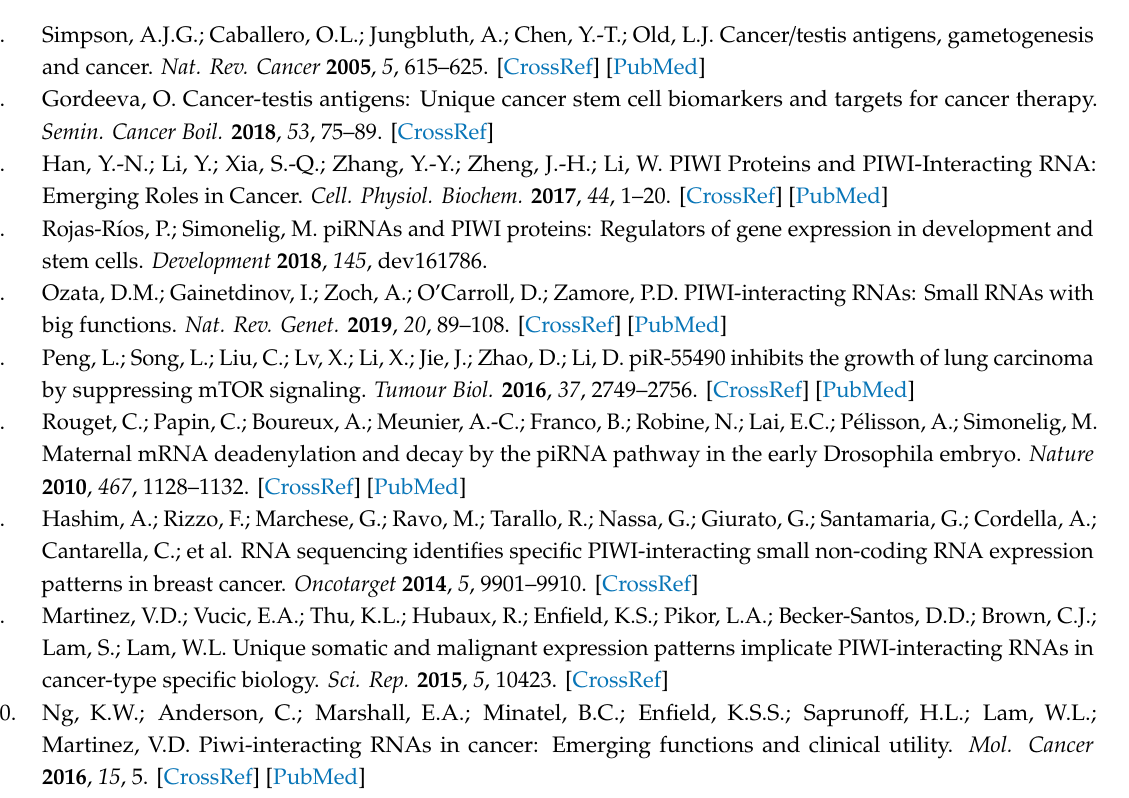
Figure S1: Expression of PIWIL2 , PIWIL3 , and PIWIL4 genes in cancer tissues; Table S1: Methylation and gene expression data of TCGA colon cancer tissues (S1A) and CRC cell lines (S1B); Figure S2: Molecular heterogeneity of PIWIL genes in tumors is maintained in CRC cell lines; Table S2: PIWIL1 CRISPR–Cas9 loss-of-function screening, Table S3: Mapping statistics of samples analyzed by small RNA sequencing; Figure S3: Small RNA profiling of CRC cell lines; Figure S4: E ff ect of the sodium periodate (NaIO 4 ) / β -elimination treatment in human testis RNA; Table S4: piRNA expression in human colon cancer cell lines and testis; Figure S5: Relative abundance of CRC piRNAs compared to the germline; Table S5: Expression of piRNA pathway genes in COLO 205; Figure S6: E ffi ciency of the sodium periodate (NaIO 4 ) / β -elimination treatment; Figure S7: Heatmaps showing the e ff ect of the NaIO 4 treatment on the piRNA population in COLO 205; Table S6: Pathway analysis of PIWIL1 loss of function in COLO 205 cells; Table S7: Relative mean ratios and count per million (CPM) values of samples treated with sodium periodate / β -elimination in the COLO 205 cell line; Table S8: Enrichment values for RIP-Seq experiment; Figure S8: Characterization of PIWIL1 subcellular distribution; Figure S9: Evaluation of subcellular distribution of PIWIL1 in the COLO 205 cell line; Figure S10: Pathway analysis of putative piRNAs mRNA targets; Table S9: Analysis of PIWIL1–piRNAs target genes in COLO 205; Supplementary